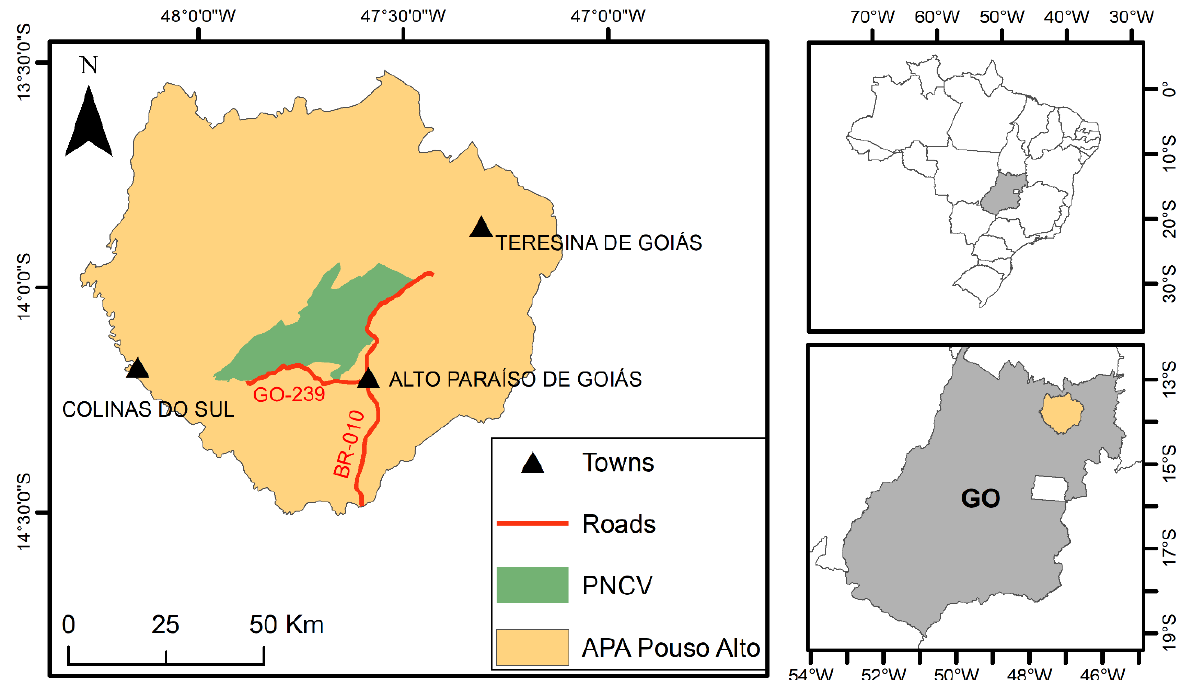
Figure 1. Monitored road stretches: BR-010 (South of Alto Paraíso de Goiás), and BR-010 (North of Alto Paraíso de Goiás)/GO-239 within the Pouso Alto APA limits in the Northeastern state of Goiás, Brazil. Towns are indicated by triangles. The Chapada dos Veadeiros National Park (PNCV) limits were updated in June 5,